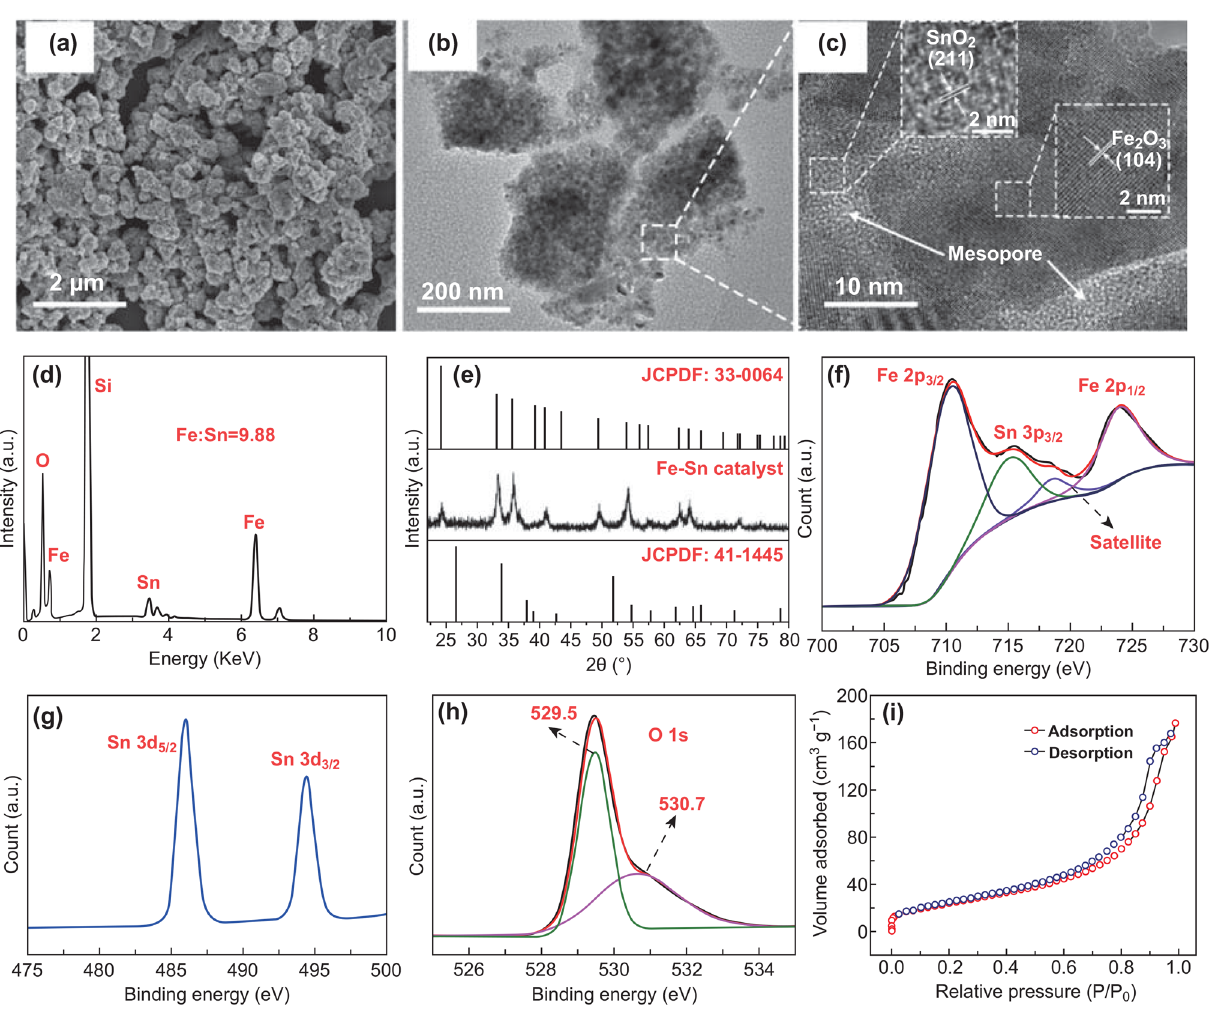
Fig. 5 Structural and component analysis of the catalysts with Fe/Sn molar ratio of 10:1. a SEM, b TEM, and c HRTEM images, d EDX, and e XRD spectra, f Fe 2p and Sn 3p, g Sn 3d, and h O 1s XPS spectra, i N 2 adsorption/desorption isotherm for the catalyst